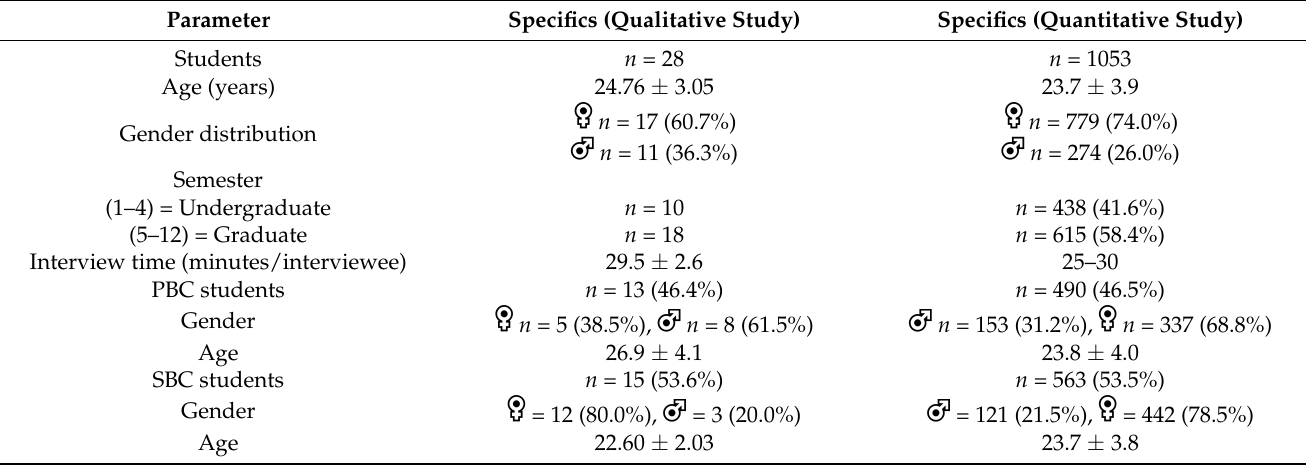
Table 1. Characteristics of the study cohorts.